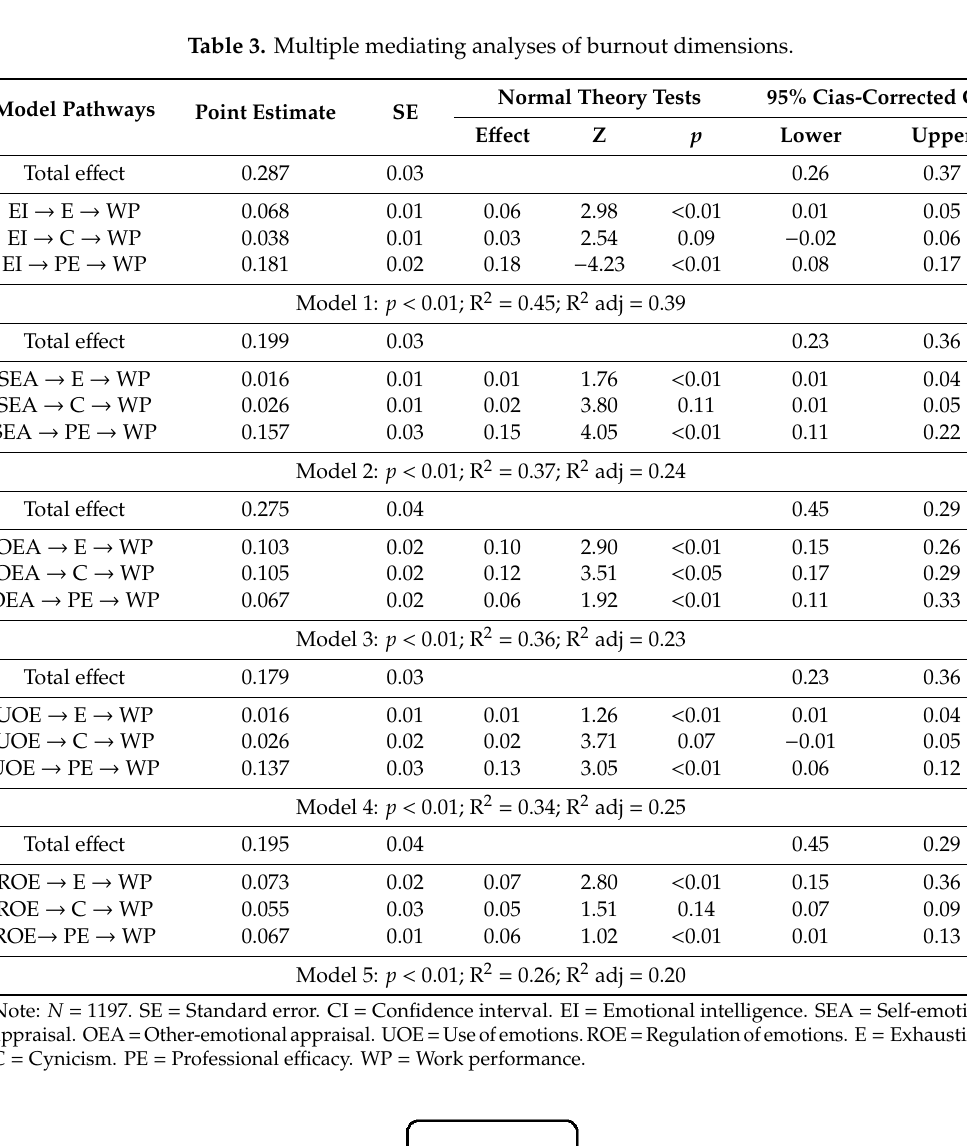
Table 3. Multiple mediating analyses of burnout dimensions.